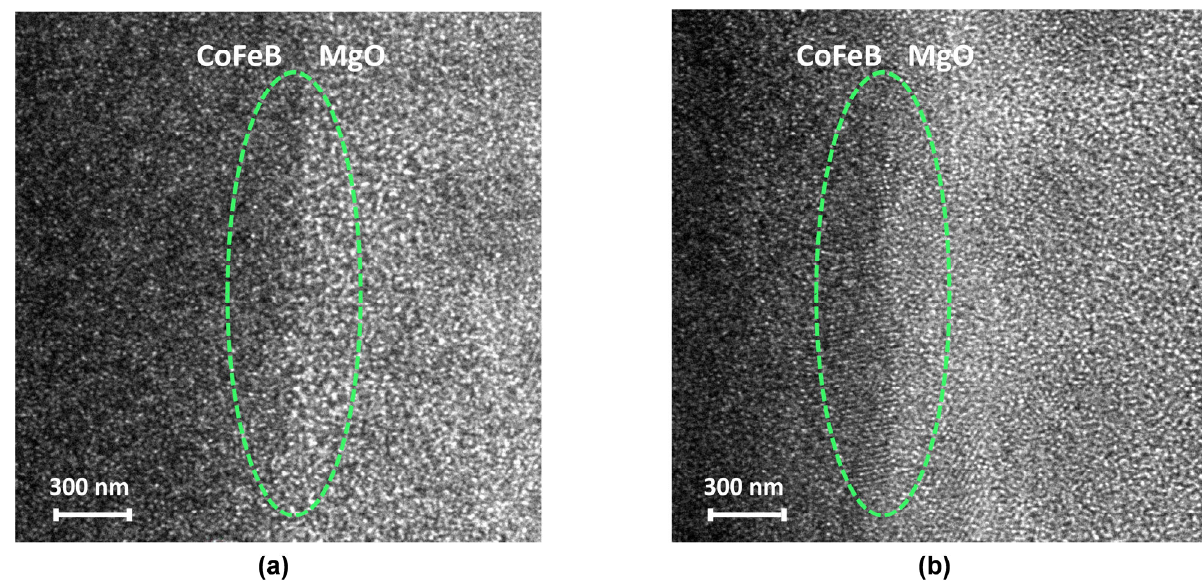
Figure 3. ( a ) TEM image of the CoFeB/MgO interface before annealing; ( b ) TEM image of the CoFeB/MgO interface after annealing.